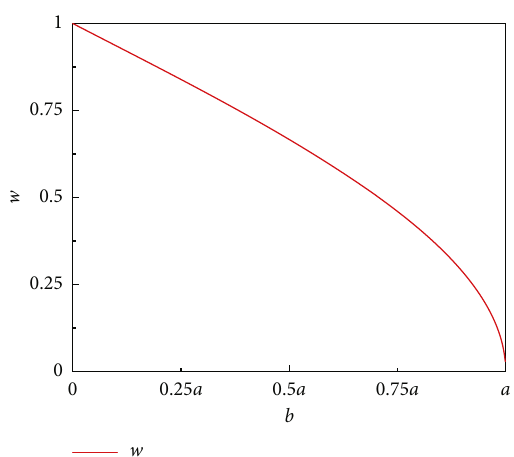
Figure 11: The relationship curve between the parameters w and b